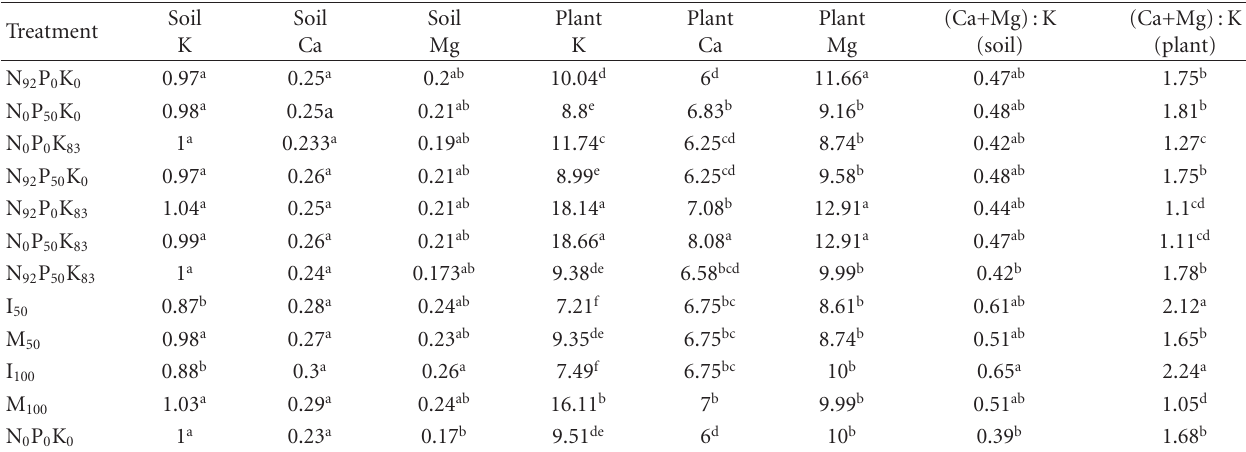
Table 6: Means of meq/100 g K, Ca and Mg and (Ca + Mg):K ratio in soil and plant.